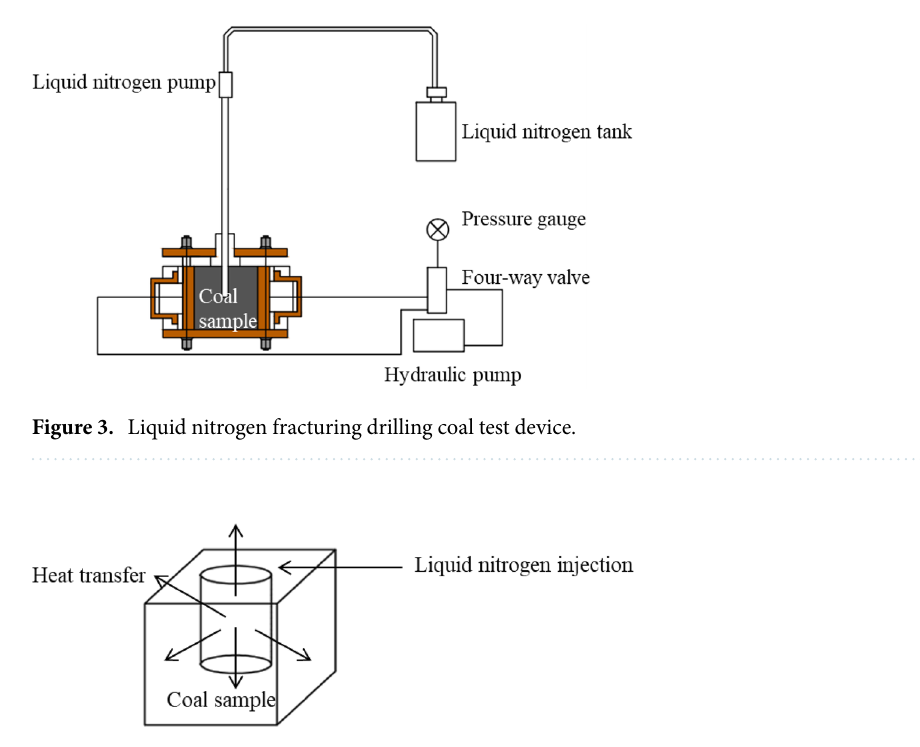
Figure 4. Schematic diagram of heat